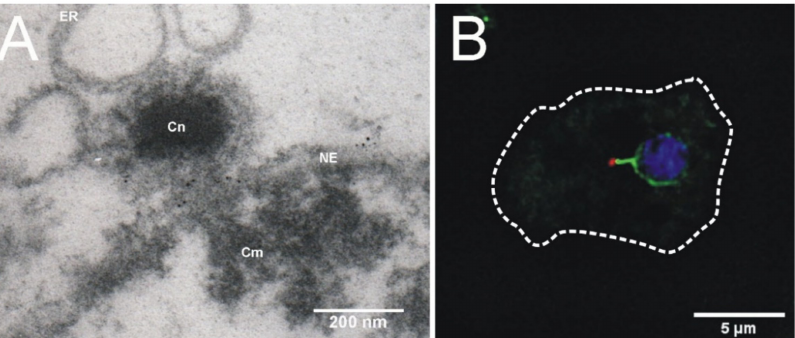
Figure 4. Centrosome-Nucleus-Centromere cluster. ( A ) Immunoelectron microscopy image showing one section of an isolated nucleus with the attached centrosome. Nuclei were labeled with an antibody against Dictyostelium Sun1 and nanogold conjugated anti-rabbit antibodies. The centrosome (Cn), the centromeric cluster (Cm), the nuclear envelope (NE) and the endoplasmic reticulum (ER) are indicated (image by Prof. Otto Baumann); ( B ) Immunofluorescence microscopy image of a Sun1-GFP knock-in cell (green) stained with an antibody against the centrosomal core protein CP91 and anti-rabbit-AlexaFluor 568 conjugates (red) and DAPI (blue). The cell edges are outlined by a dashed line. Taken from